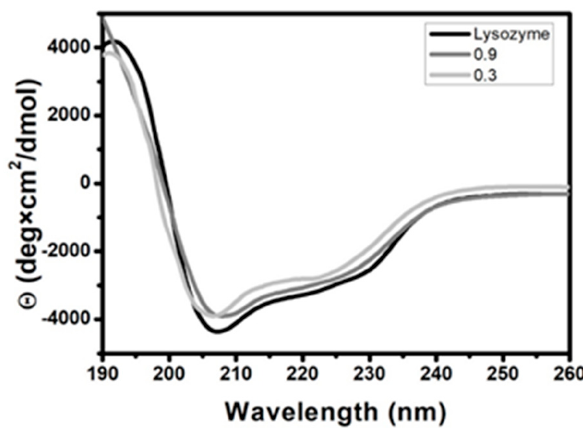
Figure 6. Circular dichroism (CD) spectra of aqueous solutions containing: Lysozyme and lysozyme/Nafion mixtures at f Lys = 0.9 and f Lys = 0.3 at 25 °C.